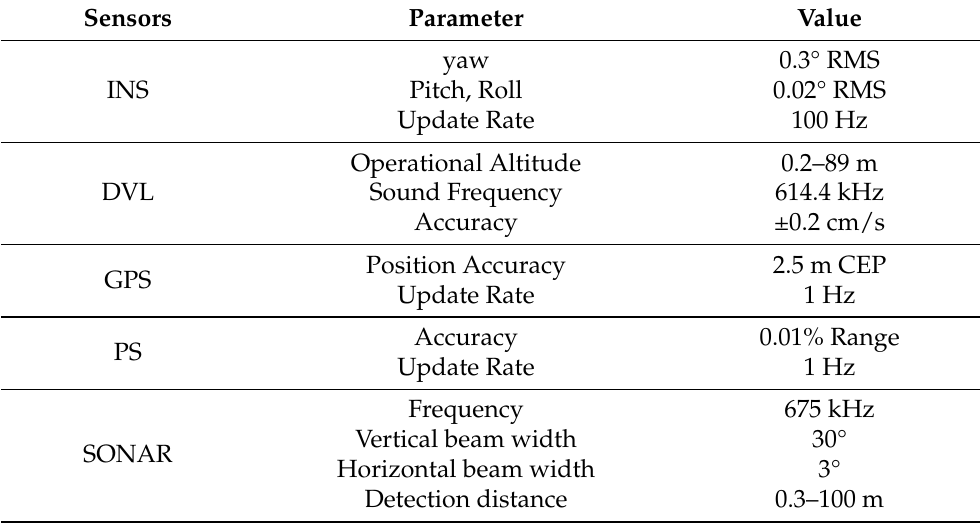
Table 1. Specifications of